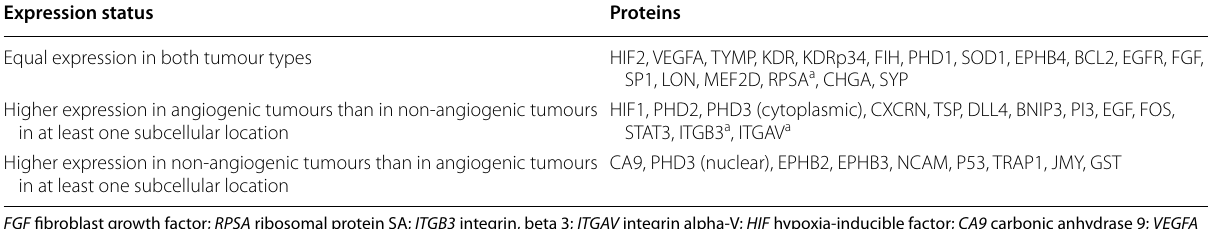
FGF fibroblast growth factor; RPSA ribosomal protein SA; ITGB3 integrin, beta 3; ITGAV integrin alpha-V; HIF hypoxia-inducible factor; CA9 carbonic anhydrase 9; VEGFA vascular endothelial growth factor A; TYMP thymidine phosphorylase; KDR vascular endothelial growth factor receptor 2; KDRp34 vascular endothelial growth factor p34; FIH factor-inhibiting HIF; PHD prolyl hydroxylase dehydrogenase; DLL4 Delta-like 4; TSP1 thymidine phosphorylase 1; CXCR4 chemokine (C-X-C motif) receptor 4; EPH ephrin; SOD1 superoxide dismutase 1; BCL2 B cell lymphoma 2; FOS FBJ murine osteosarcoma viral oncogene homolog; EGF epidermal growth factor; EGFR epidermal growth factor receptor; BNIP3 BCL2/adenovirus E1B 19 kDa interacting protein 3; PI3 peptidase inhibitor 3; SP1 Sp1 transcription factor; STAT3 signal transducer and activator of transcription 3; LON Lon protease; MEF2D myocyte enhancer factor 2D; JMY junction-mediating and regulatory protein, p53 cofactor; TRAP1 TNF receptor-associated protein 1; GST glutathione S-transferase; NCAM neural cell adhesion molecule; CHGA chromogranin A; SYP synaptophysin a Data for RPSA are from Ref. [18] and for ITGB3 and ITGAV are from Ref. [23]